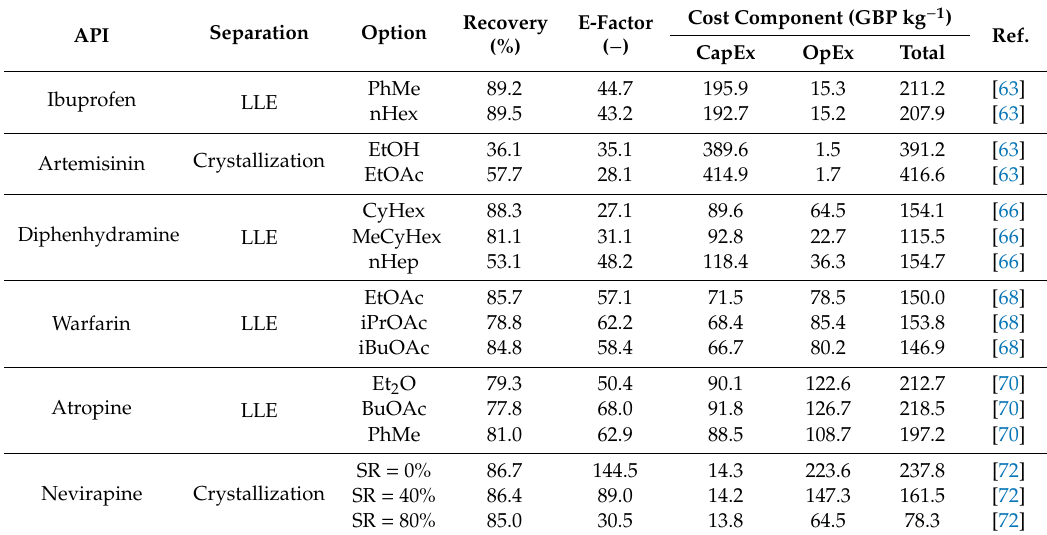
Table 2. Summary of performance metrics for each API case study (listed in Table